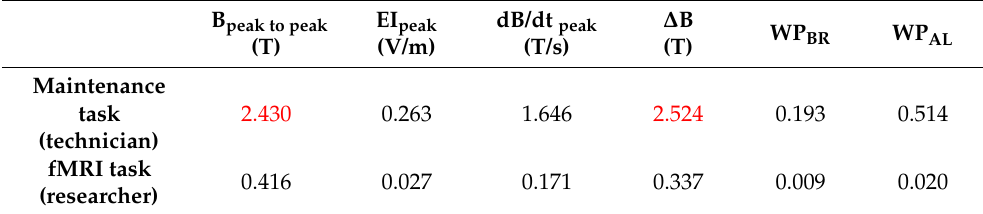
Table 1. Peak value for calculated exposure parameters. Red values represent the exceeded limits.